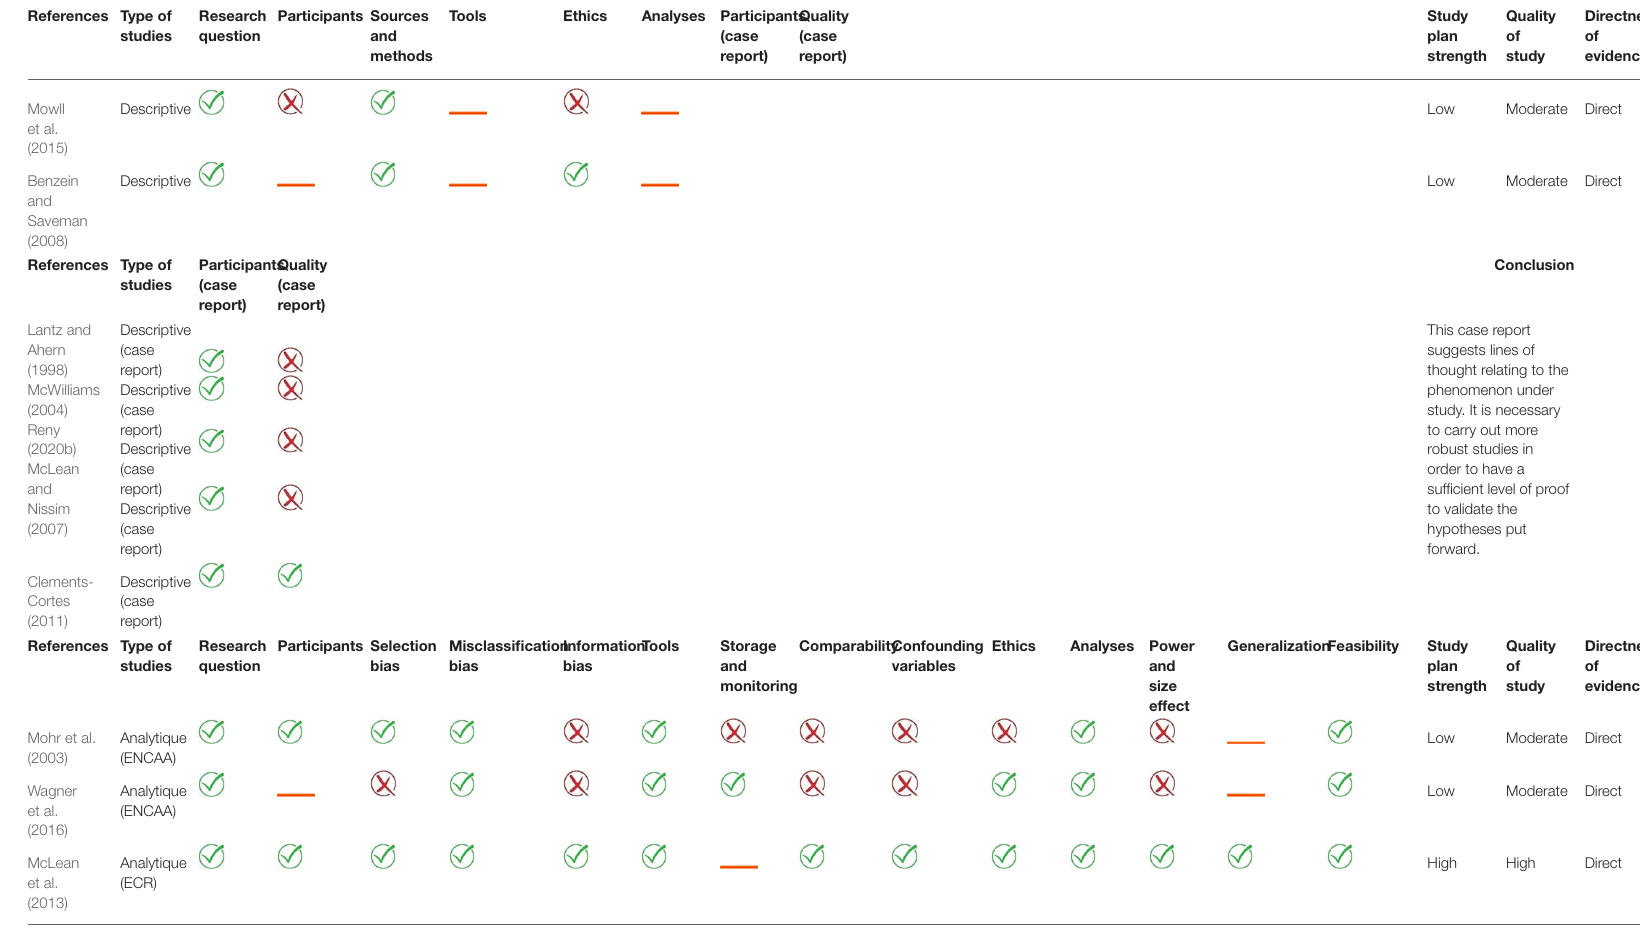
TABLE 4 | Quality assessment of the included studies of dyadic interventions of the patient and his/her life partner when confronted with advanced